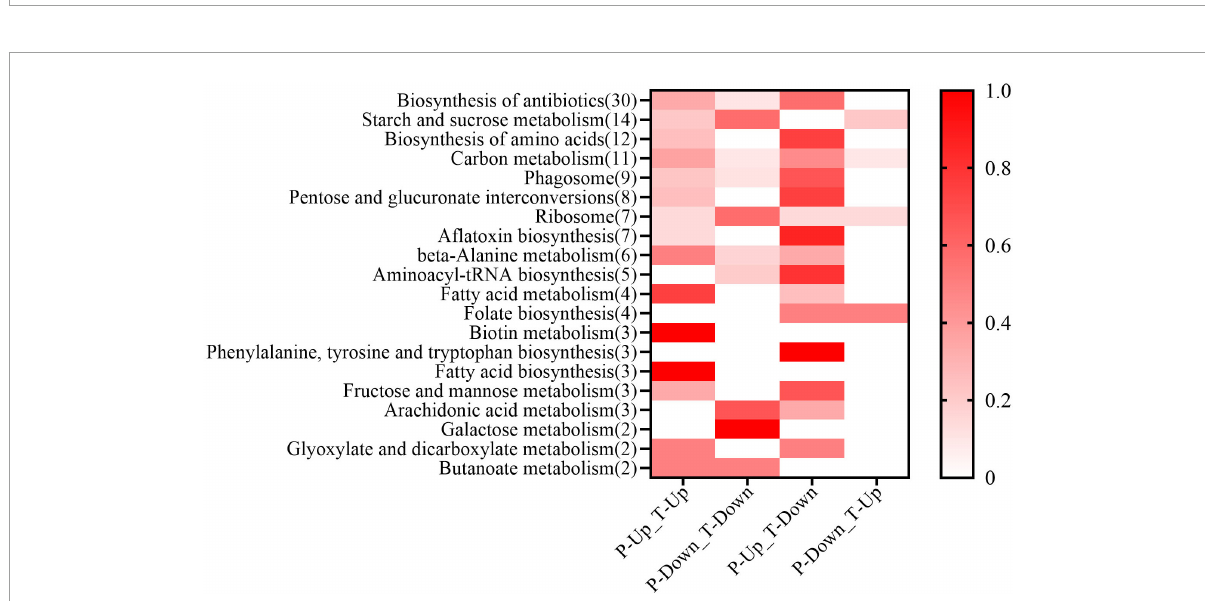
FIGURE4 Proteome–transcriptome-associated Kyoto Encyclopedia of Genes and Genomes (KEGG) analysis. In the horizontal axis, T, P, Up, and Down show differentially expressed genes from the transcriptome, differentially abundant proteins from the proteome, up-regulation, and down-regulation, respectively. On the Y axis, the number of differentially abundant proteins in each pathway is shown in parentheses. The color of the heat map represents the proportion of proteins in the